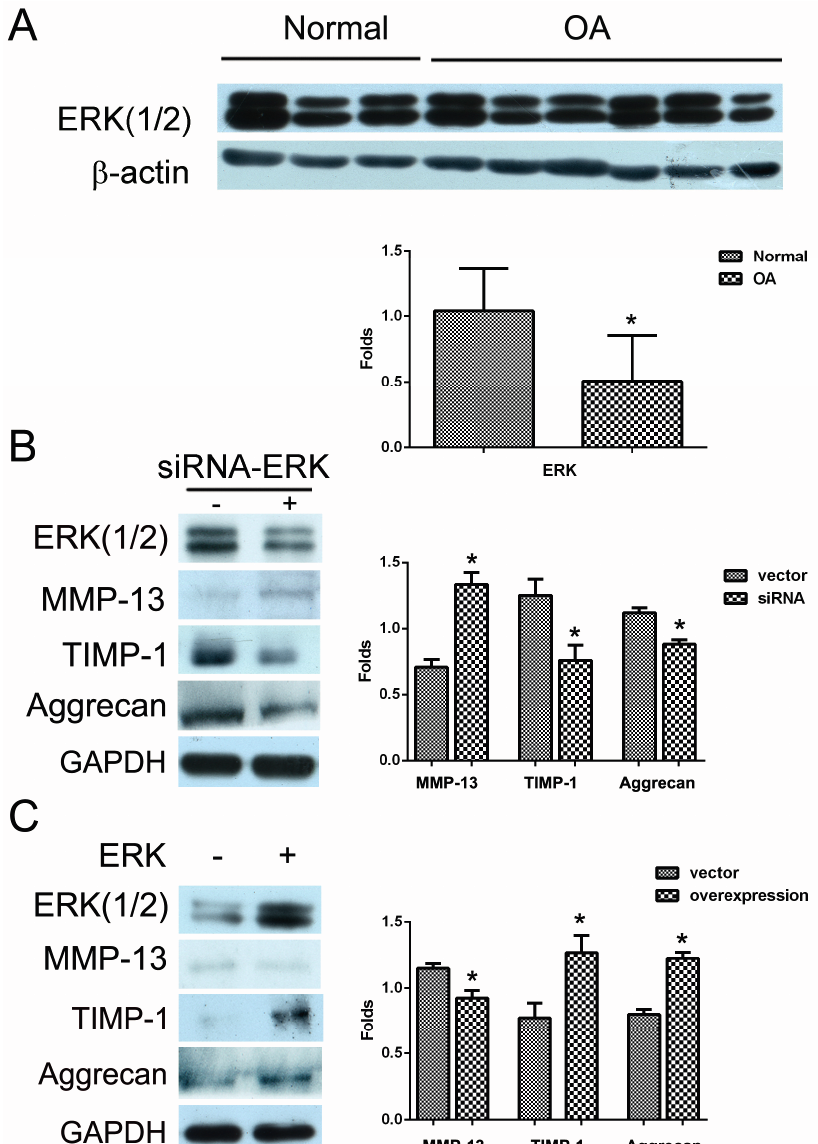
Figure 1. The effect of ERK on matrix synthesis in human OA chondrocytes. ( A ) Normal and OA chondrocytes were cultured, and the level of ERK(1/2) was detected by Western blotting analysis using anti-ERK(1/2) and β -actin antibodies; ( B ) Cells were transfected with siRNA/ERK vector for seven days and the levels of MMP-13, TIMP-1 and Aggrecan were detected by Western blotting analysis using anti-MMP-13, TIMP-1, Aggrecan and GAPDH antibodies; ( C ) Cells were transfected with ERK vector for two days and the levels of MMP-13, TIMP-1 and Aggrecan were detected by western blotting analysis using anti-MMP-13, TIMP-1, Aggrecan and GAPDH antibodies. The blots were normalized to an endogenous protein ( β -actin or GAPDH). The values represent the mean ± SEM of three or five independent experiments (patients), each yielding similar results ( * p <